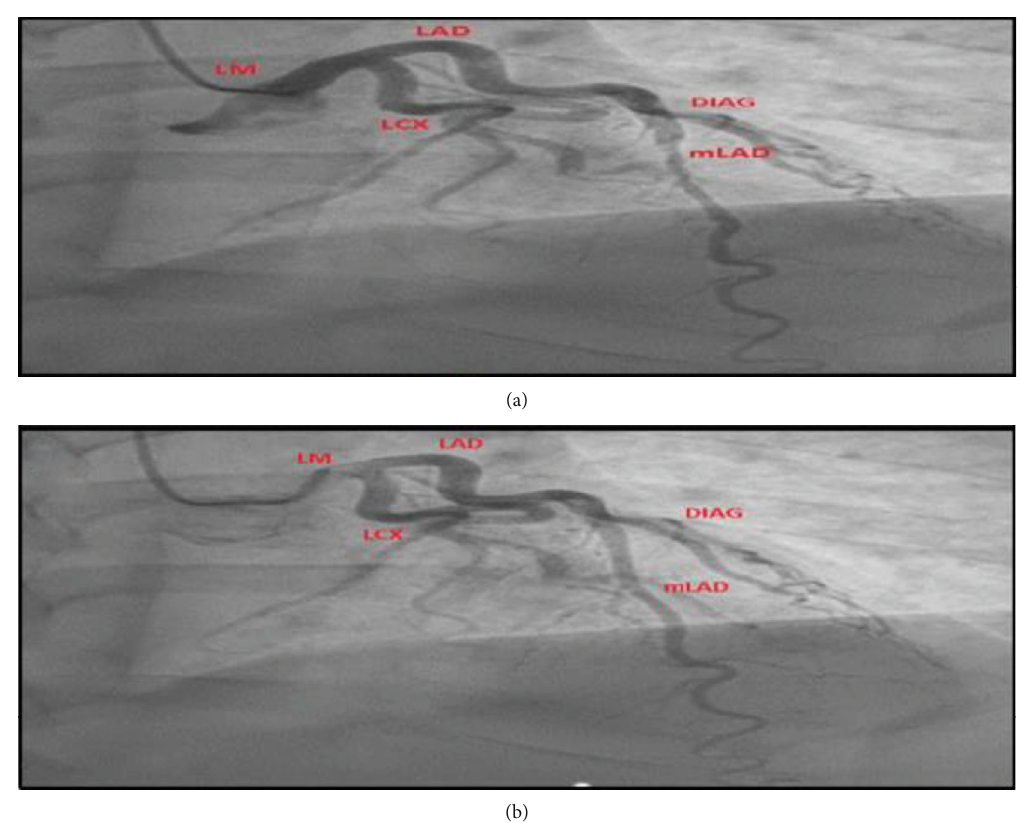
Figure 2: (a) RAO cranial LHC demonstrating signi fi cant middle-LAD stenosis during systole. (b) RAO cranial LHC demonstrating patent middle-LAD during